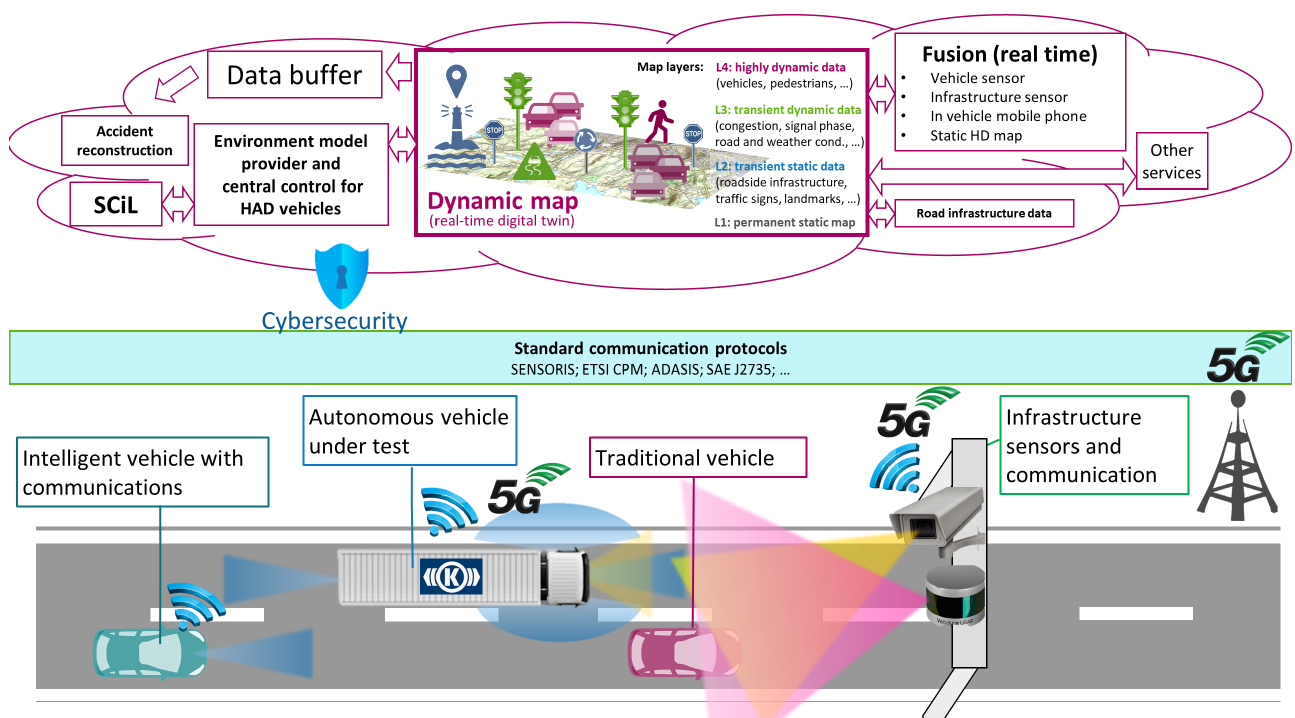
Figure 1. The goals of the international project “Development of central system architecture for autonomous vehicle testing and operation related services (2019-2.1.14-ÖNVEZET